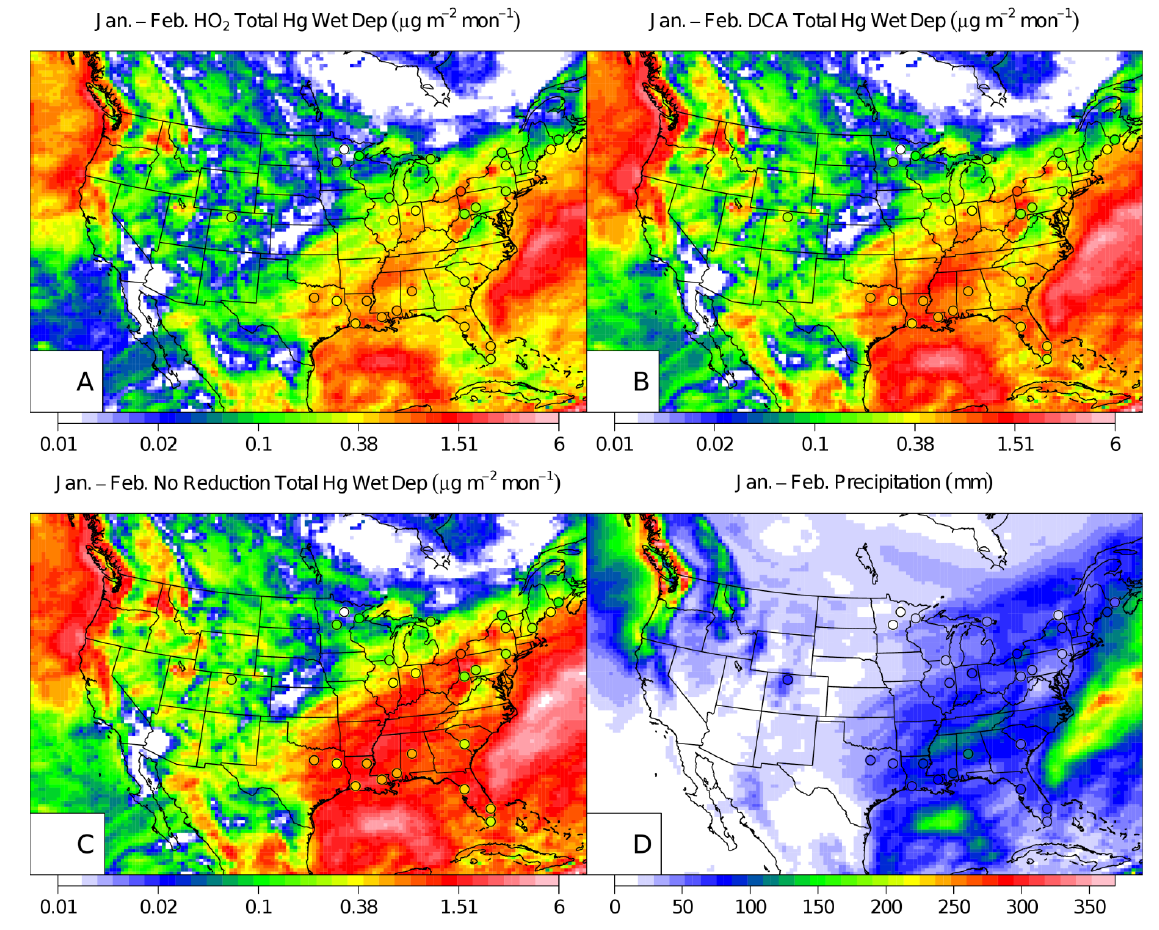
Figure 2 . CMAQ January and February 2002 wet deposition with MDN observations (points) for the HO aqueous-phase reduction case ( A ), the DCA reduction case ( B ), NAR 2 ( C ), and a map of the precipitation ( D ). Note, only the MDN measurement sites that had a complete set of observations over the two-month period were plotted.